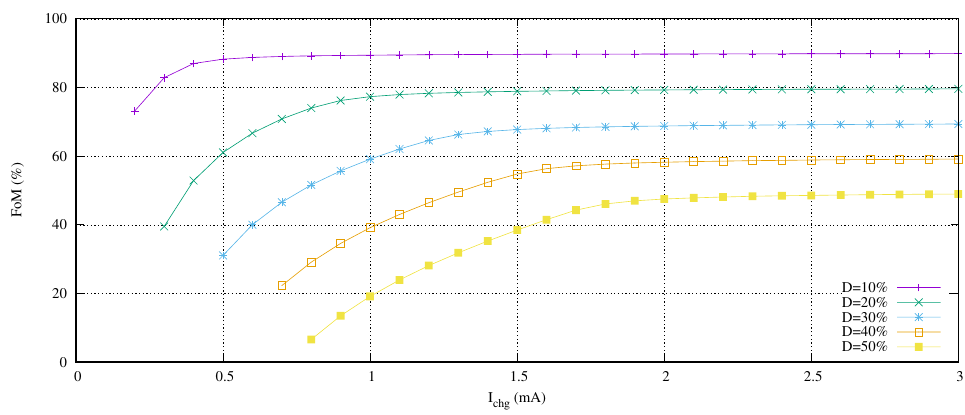
Figure 10. FoM, charging current and duty cycle behavior for a given experiment with T = 900 s.